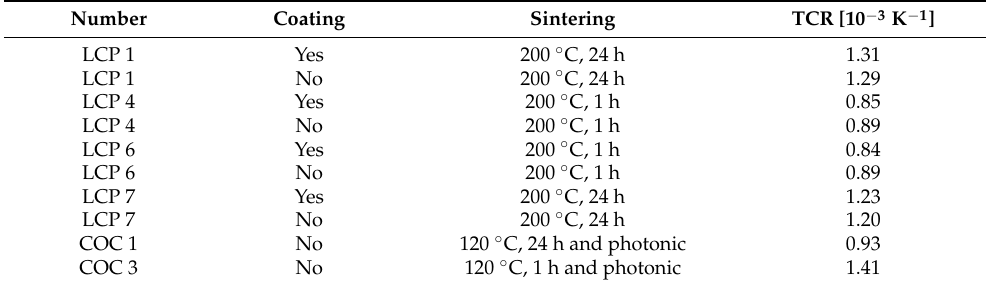
Figure 9. Inkjet-printed temperature sensor, which shows high hysteresis and non-repeatability. Table 3. Temperature coefficient of resistance (TCR) for inkjet-printed temperature sensors on LCP and COC substrates.